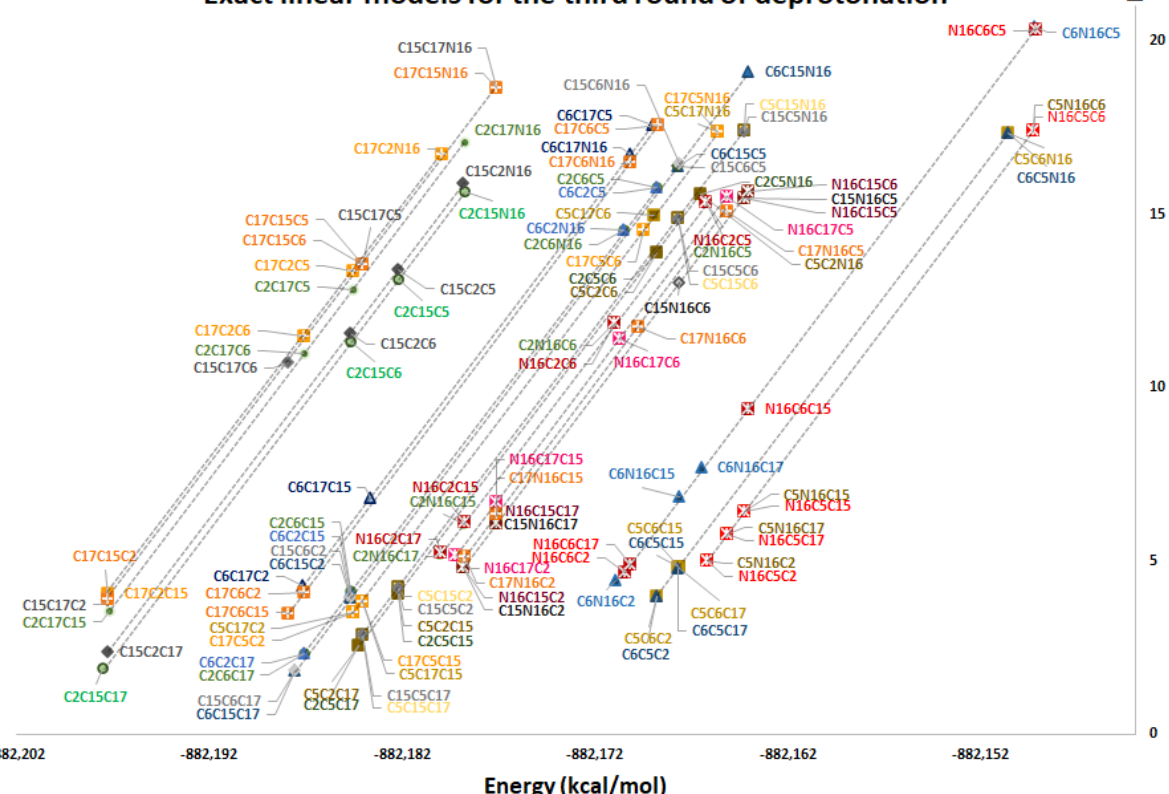
Figure 14. pK a calculation used a direct approach for the third round of deprotonation.